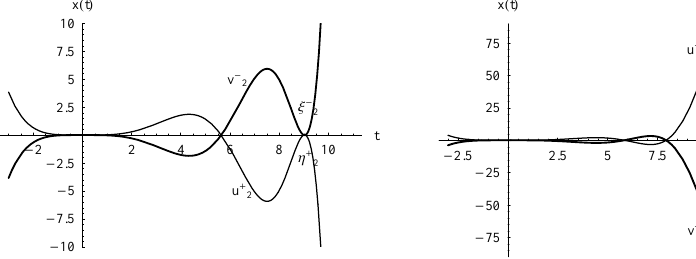
( t ) Figure 4. The extremal functions u + 2 (3.3) which relate to η + which relate to ξ −